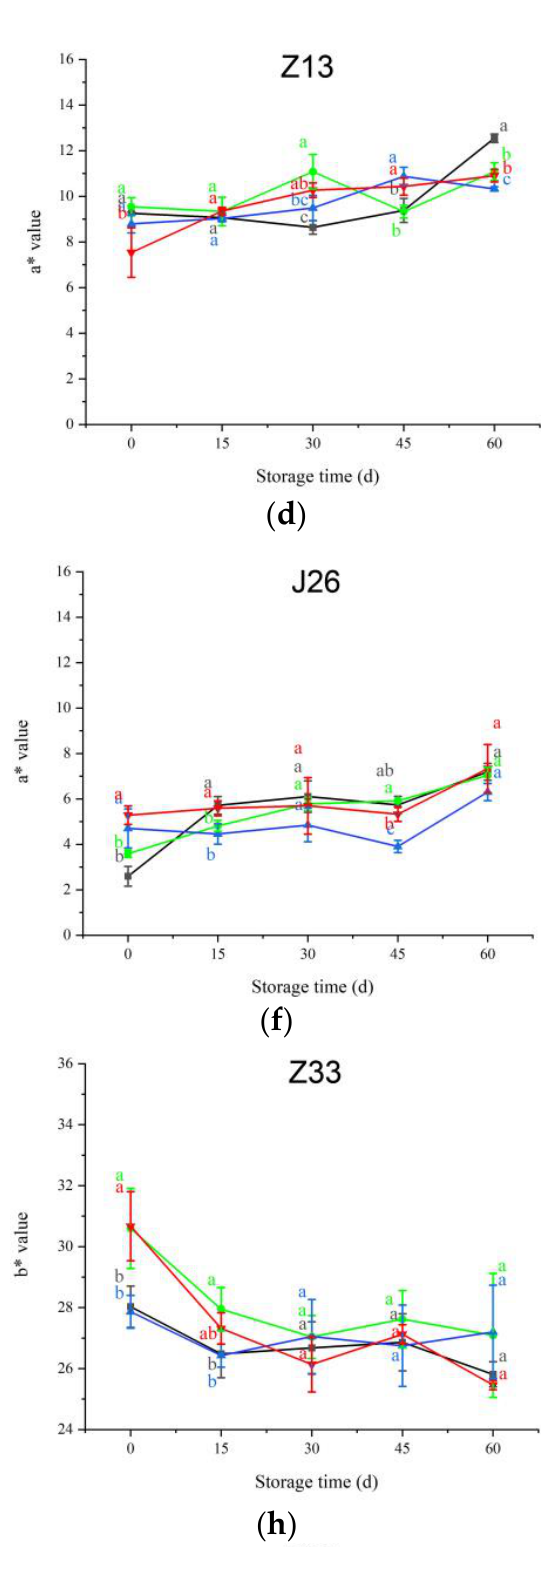
( l ) Figure 5. Flesh color of the tuberous root of different UCZ treatments during storage. ( a ) L* value of Z13; ( b ) L* value of Z33; ( c ) L* value of J26; ( d ) a* value of Z13; ( e ) a* value of Z33; ( f ) a* value of J26; ( g ) b* value of Z13; ( h ) b* value of Z33; ( i ) b* value of J26; ( j ) C* value of Z13; ( k ) C* value of Z33; ( l ) C* value of J26. Values within the same storage day of the same year followed by the same letter are not significantly different at the 5% level according to ANOVA- Duncan’s multiple range